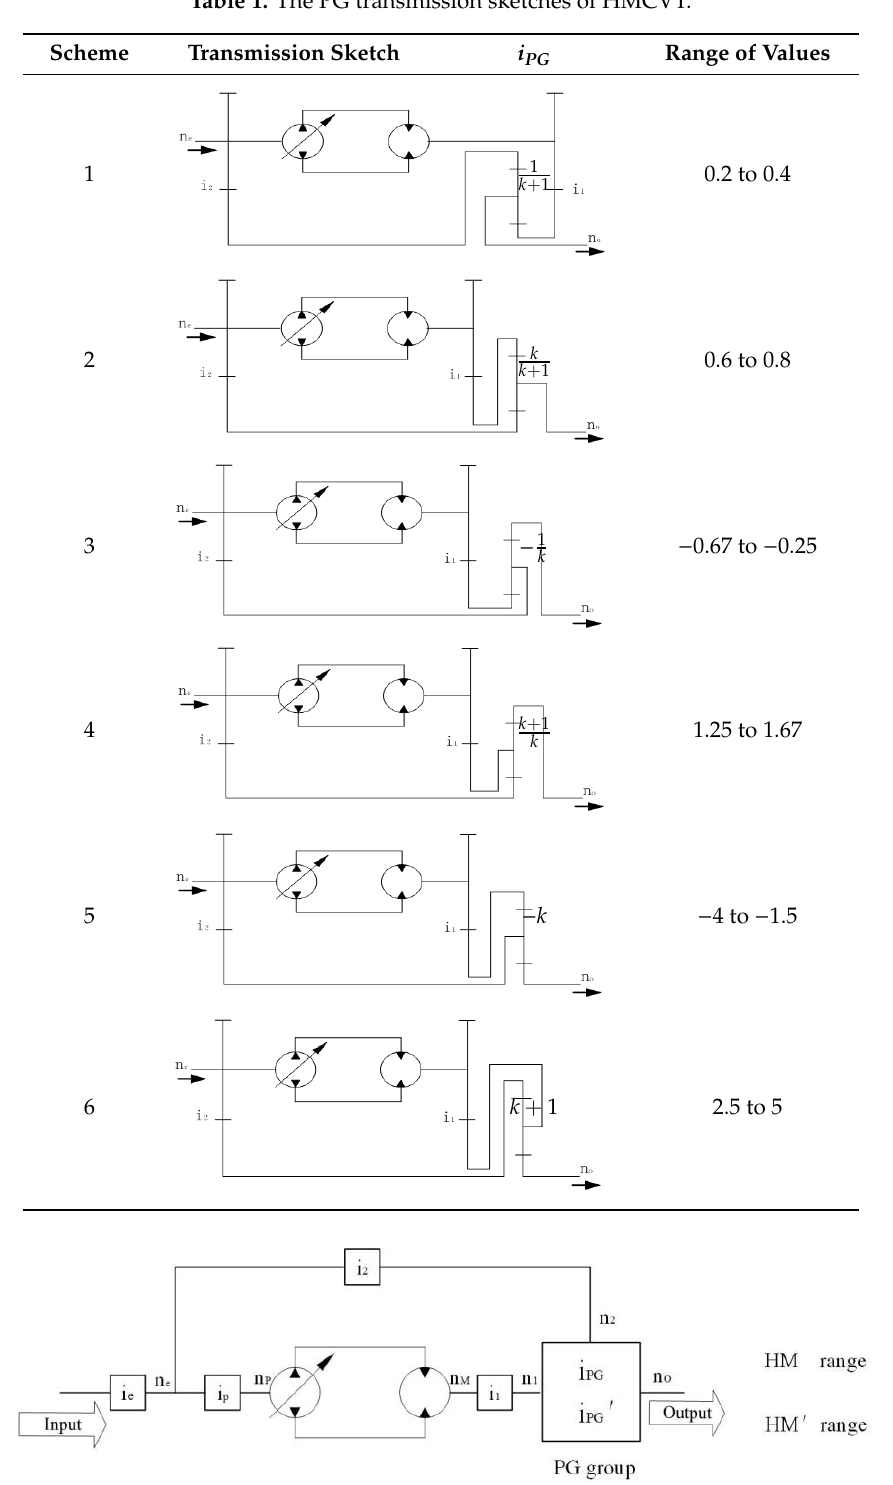
Figure 8. Input coupling type of the multi-range HMCVT.